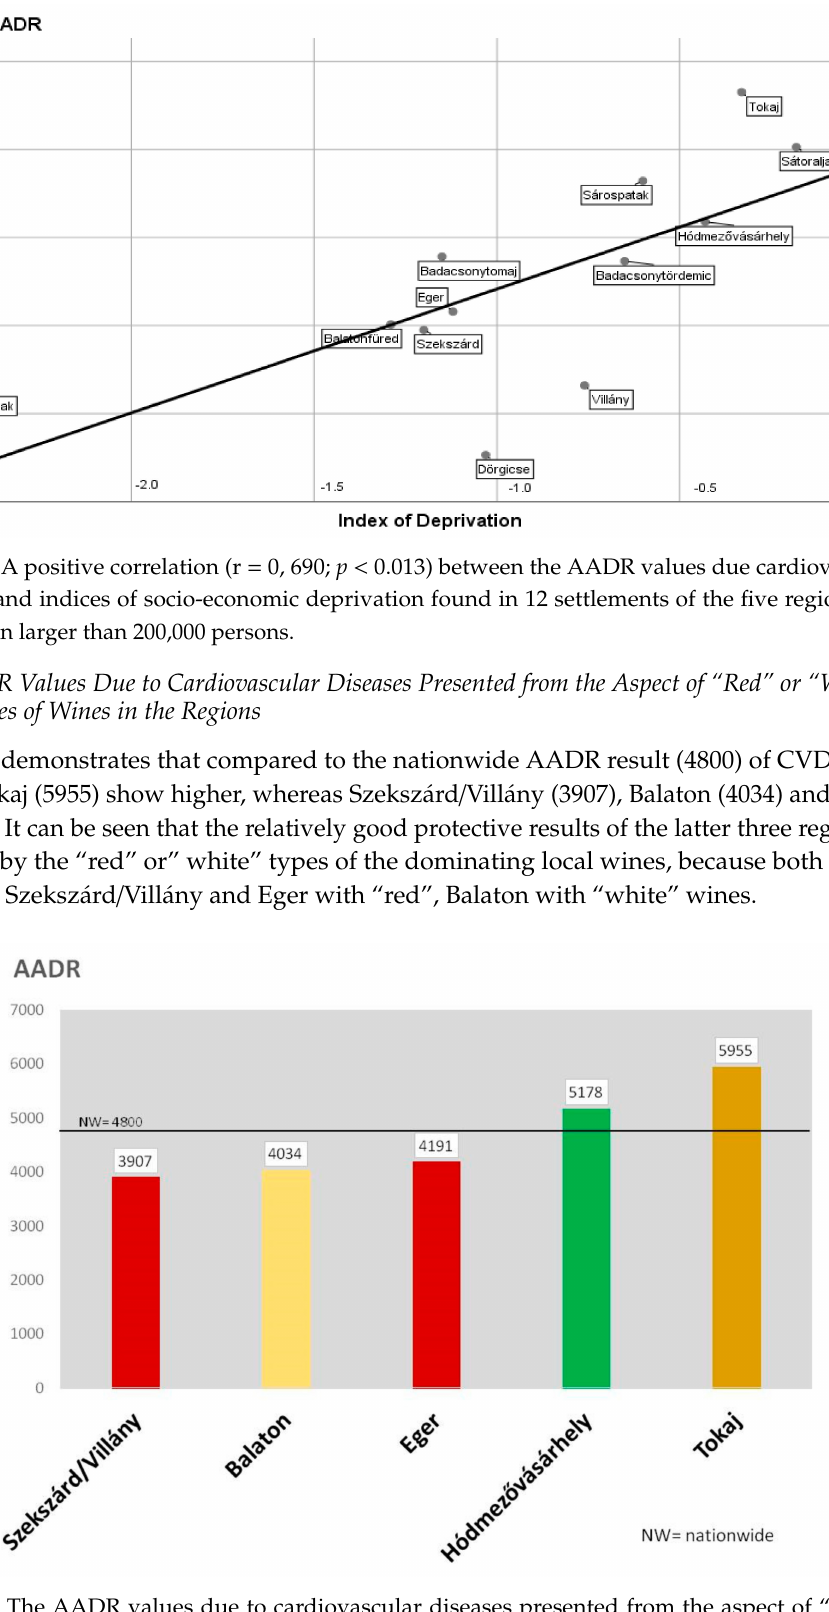
Figure 3. The AADR values due to cardiovascular diseases presented from the aspect of “red” or “white” dominant types of wines in the